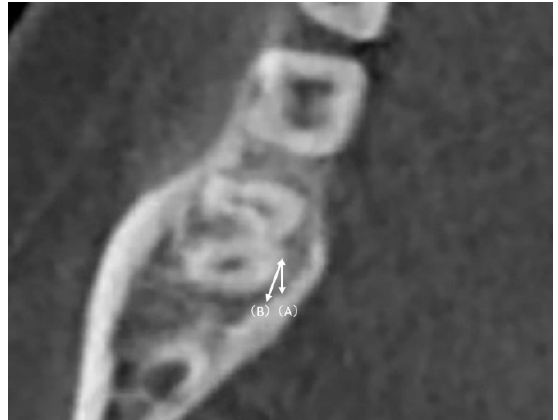
Figure 4. Definition of the mandibular posterior anatomic limit as measured in this study. Distances from the most lingual point of the distal root of the right mandibular second molar: (A) Distance from the medial side of the mandibular cortex of the lingual bone along the sagittal plane. (B) Distance from the medial margin of the mandibular cortex of the lingual bone along the cuspal line.